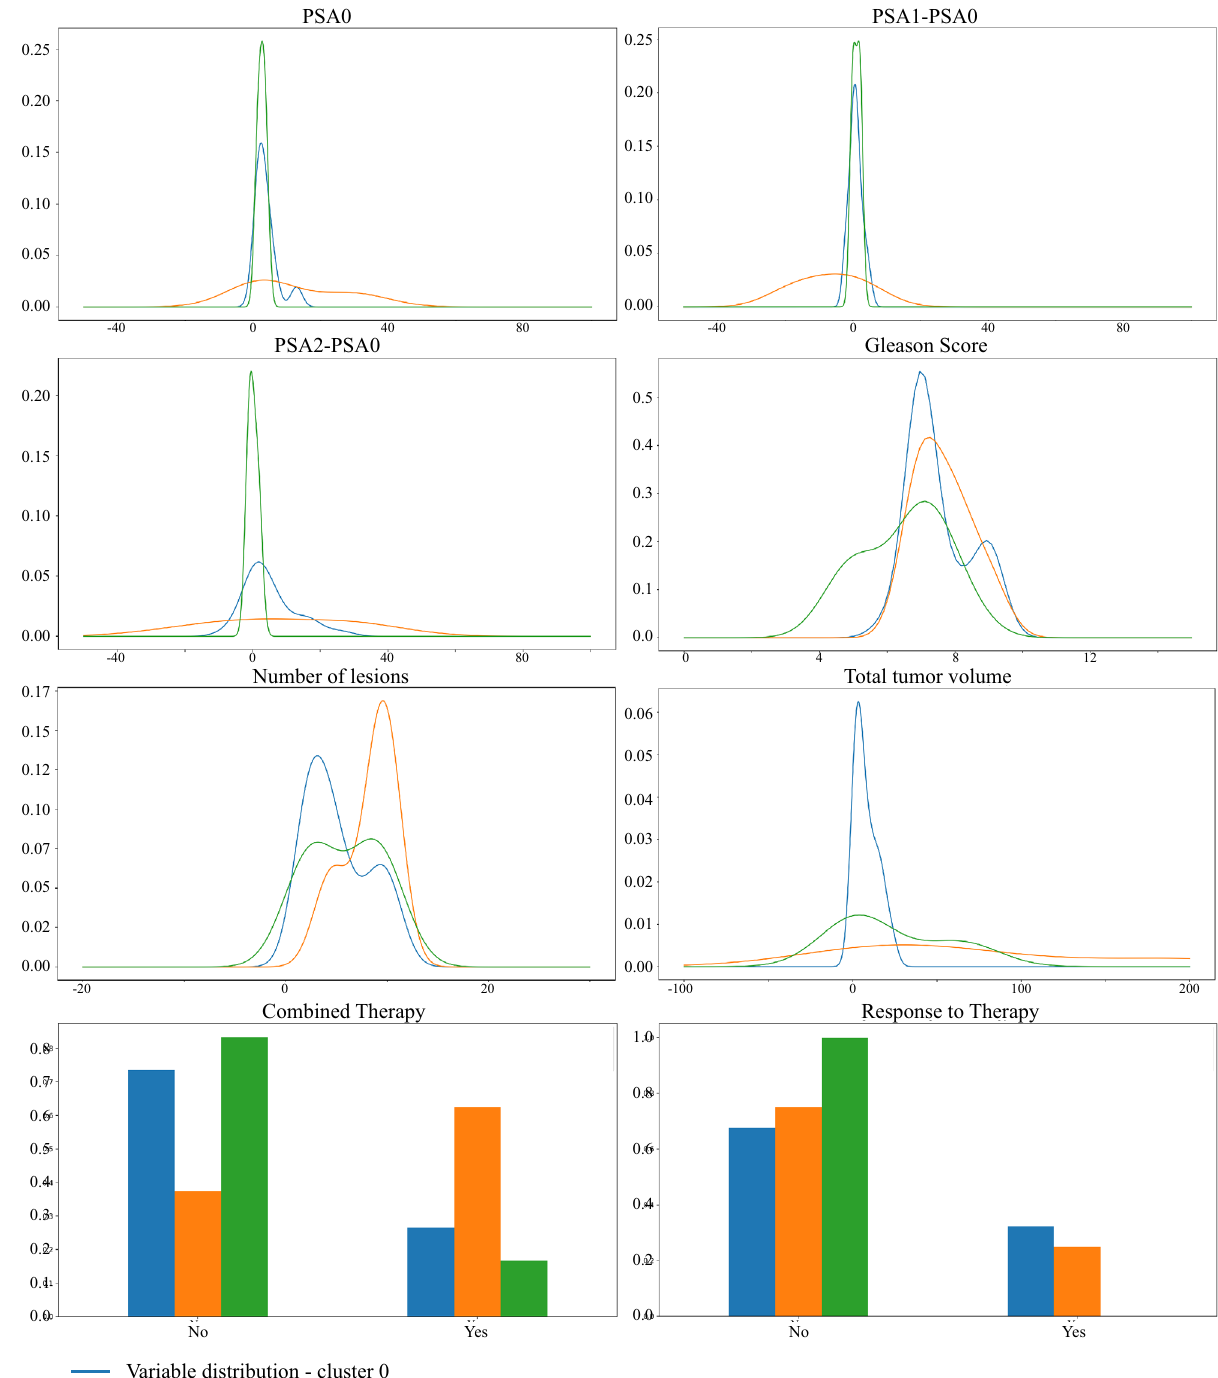
Figure 3. Results of clustering characterization: the first three rows draw the distributions of the numerical clinical variables in the three groups, namely the PSA values, the (cid:31) PSA 1,0 , the (cid:31) PSA 2,0 , the number of lesions, Gleason Scores and the total tumor volume; the last row shows the proportions of the categorical clinical variables in the three groups, that are the combination of therapy and the response to treatment. For the proportion of skeleton disease and of the oligo/multi-metastatic status as devised by the two clinical cut-offs (3 and 5 lesions) see Section 8 of Supplementary Materials